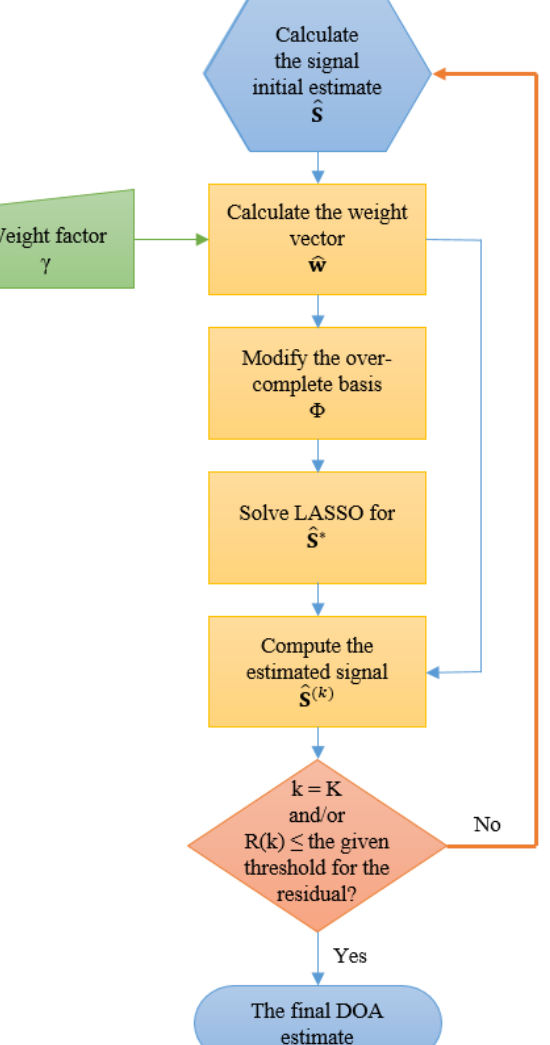
Figure 1. A flowchart of the algorithm for adaptable (A)-LASSO-based DOA